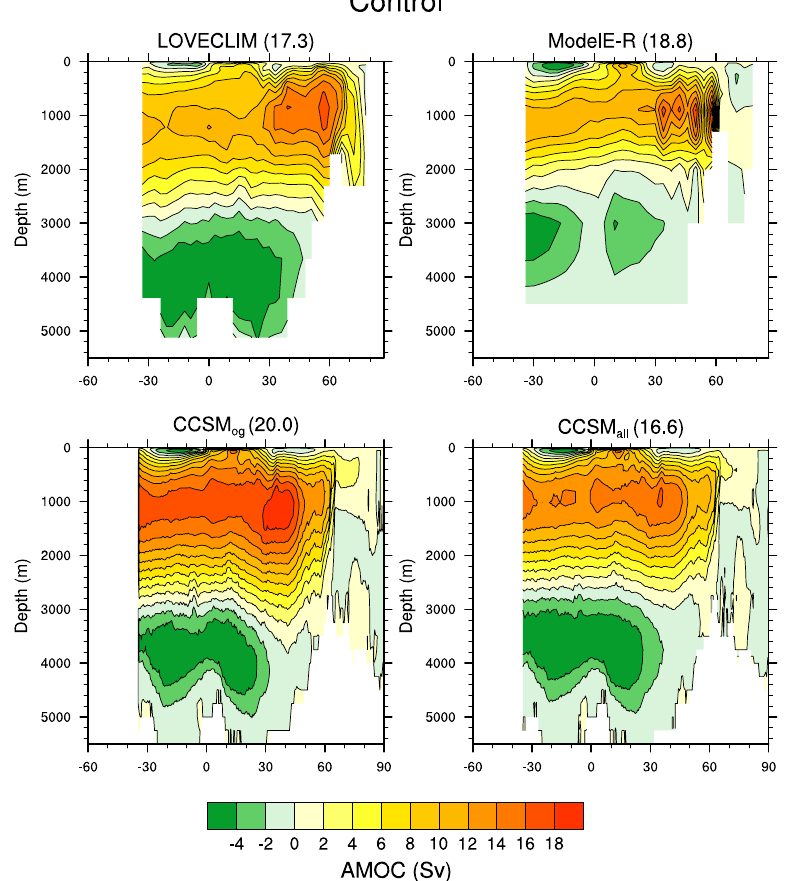
Fig. 1. The Atlantic meridional overturning streamfunctions of the control simulations (see Table 2), in Sv (1Sv = 10 6 m 3 s − 1 ). Plotted values are 200yr means except for CCSM og , which is a 150yr mean. Values in parentheses following the model names are long-term means for the maximum of the streamfunction below 500m water